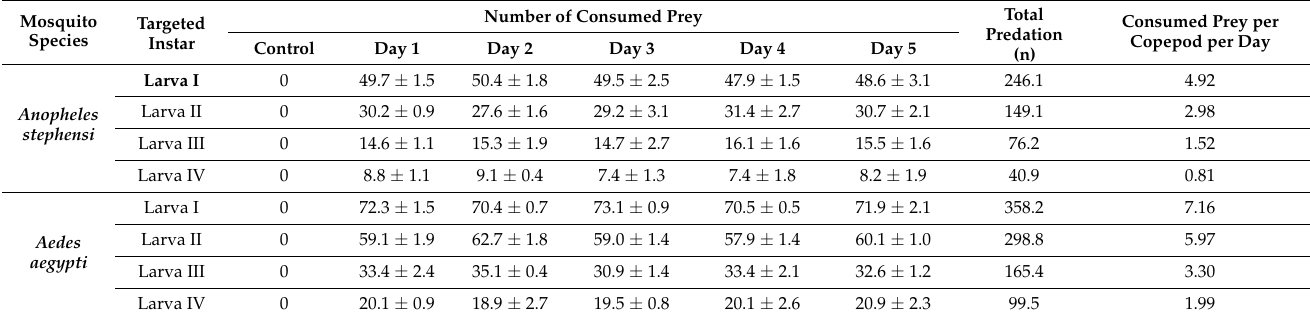
Table 2. Predation efficiency of the copepods against larvae of Anopheles stephensi and Aedes aegypti after treatment with